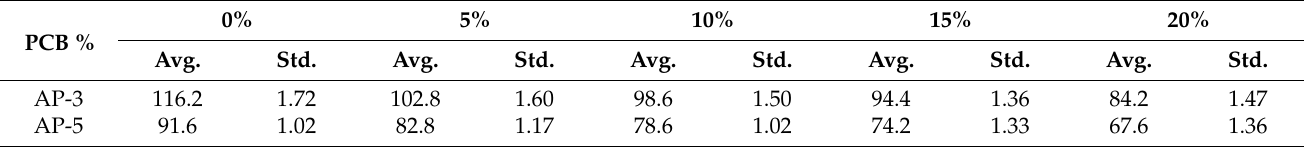
Figure 3. Testing setup and equipment for conventional test of asphalt binder. ( a ) Penetration test. ( b ) Flash point. Table 3. Penetration test for the modified asphalt binder (unit: 0.1 mm).